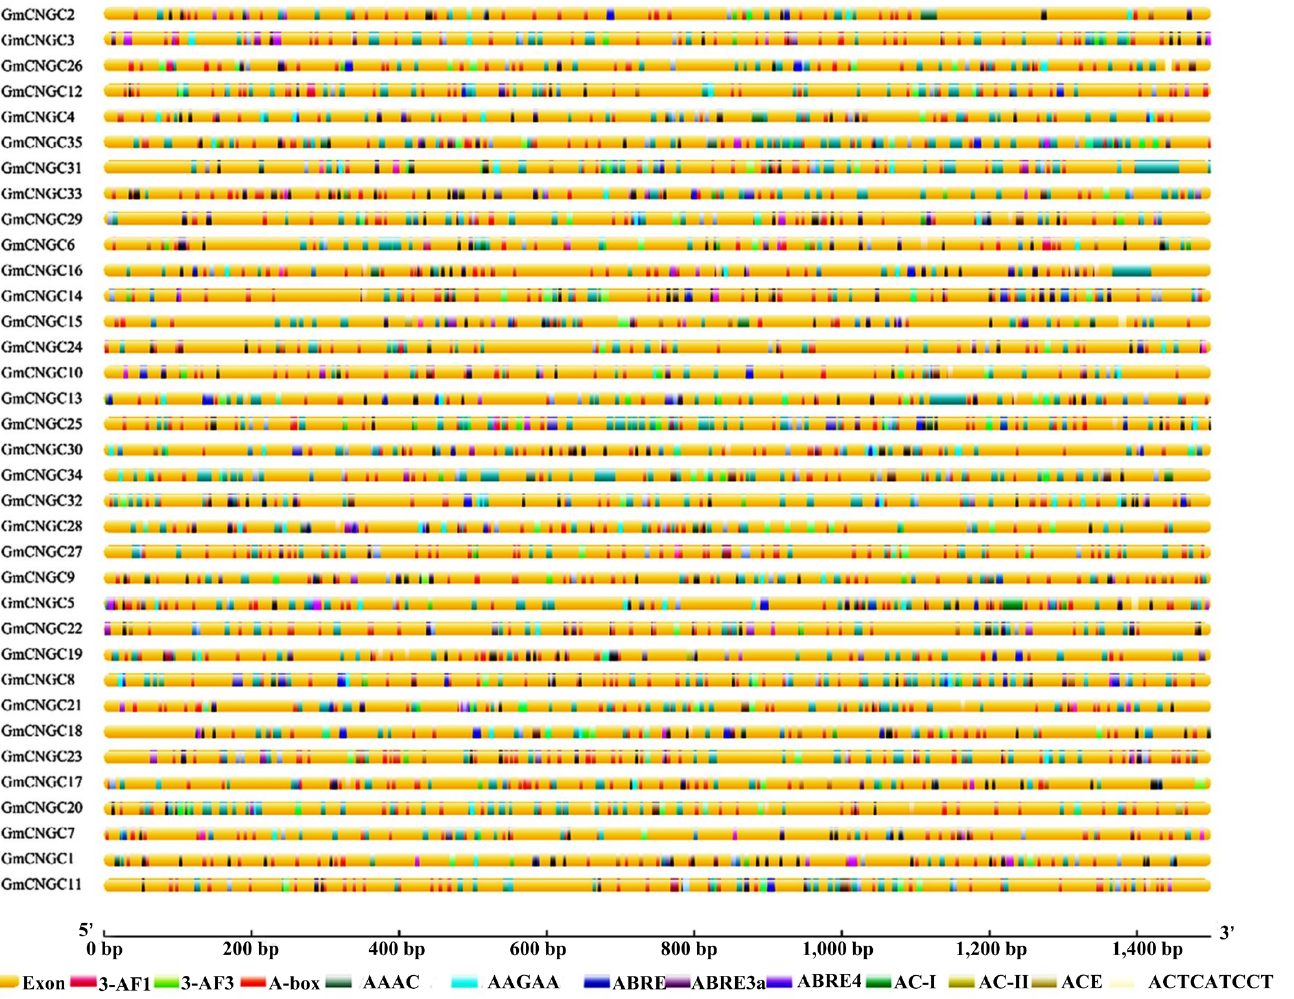
F igure 5. Cis-acting elements of the promoter sequence of CNGC genes in G. max . Figure 5. Cis-acting elements of the promoter sequence of CNGC genes in G. max